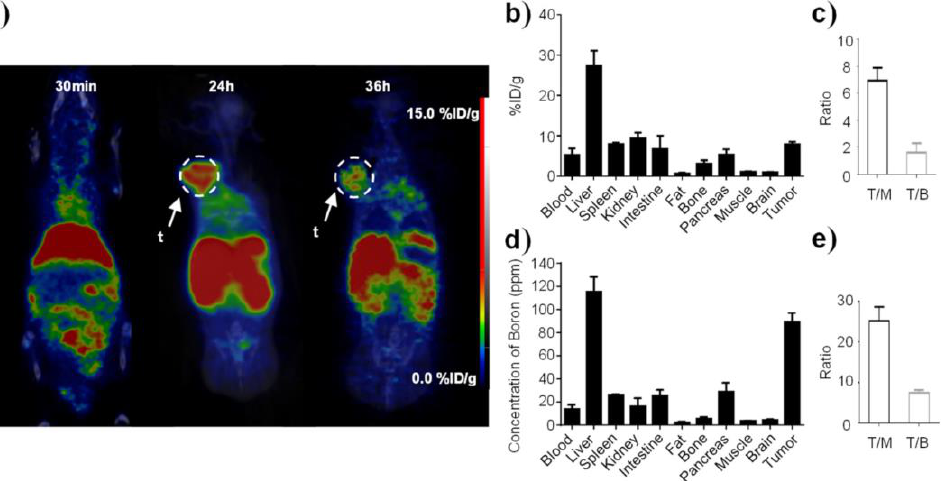
Figure 4. In vivo biodistribution of 64 Cu-DSPE-BCOP-5T in 4T1 tumor-bearing mice. ( a ) Representative whole-body coronal PET/CT fusion image of 64 Cu-DSPE-BCOP-5T at different times postinjection. The tumor (t) is indicated by the white arrow (n = 3). ( b ) Ex vivo biodistribution of 64 Cu-DSPE-COP-5T in 4T1 tumor-bearing mice 24 h postinjection (mean ± SE, % ID/g) (n = 6). ( c ) Tumor-to-muscle (T/M) and tumor-to-blood (T/B) ratios of 64 Cu-DSPE-COP-5T. ( d ) Boron concentrations in the indicated organs after three separate injections of DSPE-BCOP- 5T (mean ± SE, μg/g) (n = 6). ( e ) Tumor-to-muscle (T/M) and tumor-to-blood (T/B) ratios of boron concentrations. Reproduced with permission from Shi et al. [110], 2020.